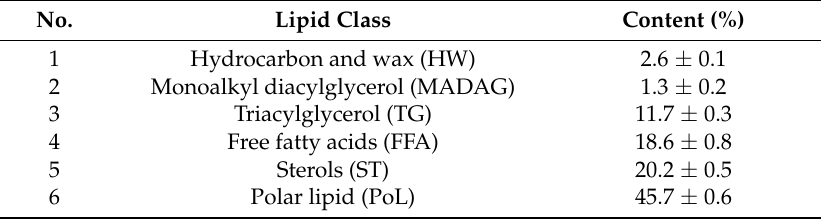
Figure 1. TLC determination of lipid classes of the clams. Table 1. Composition of main lipid classes (% of total lipid) of the